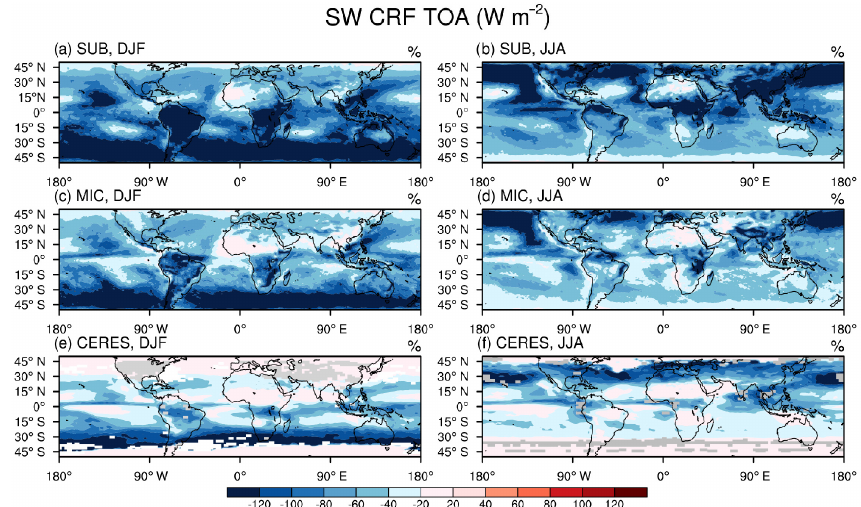
Figure 7. Simulated 10-year mean TOA SW radiation budget for DJF (left panels) and JJA (right panels) by SUB and MIC and CERES observations. Grey areas indicate missing